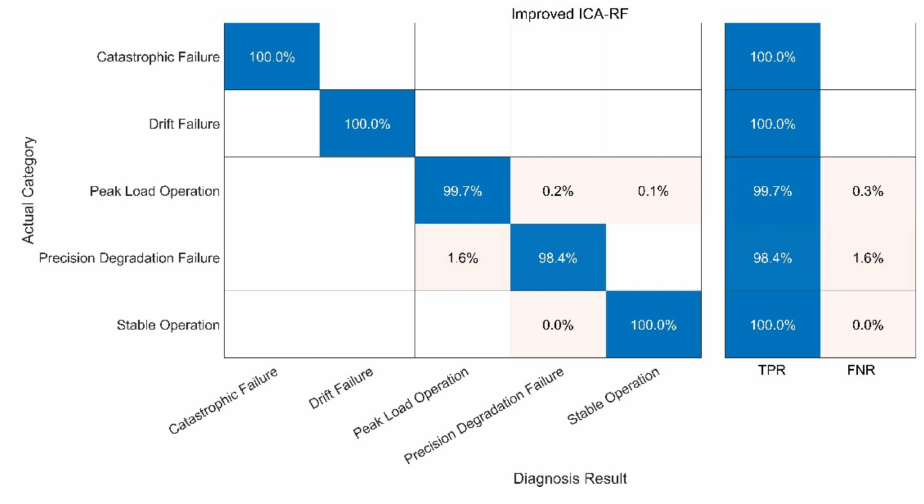
Figure 13. Fault Diagnosis Result of ICA-RF.